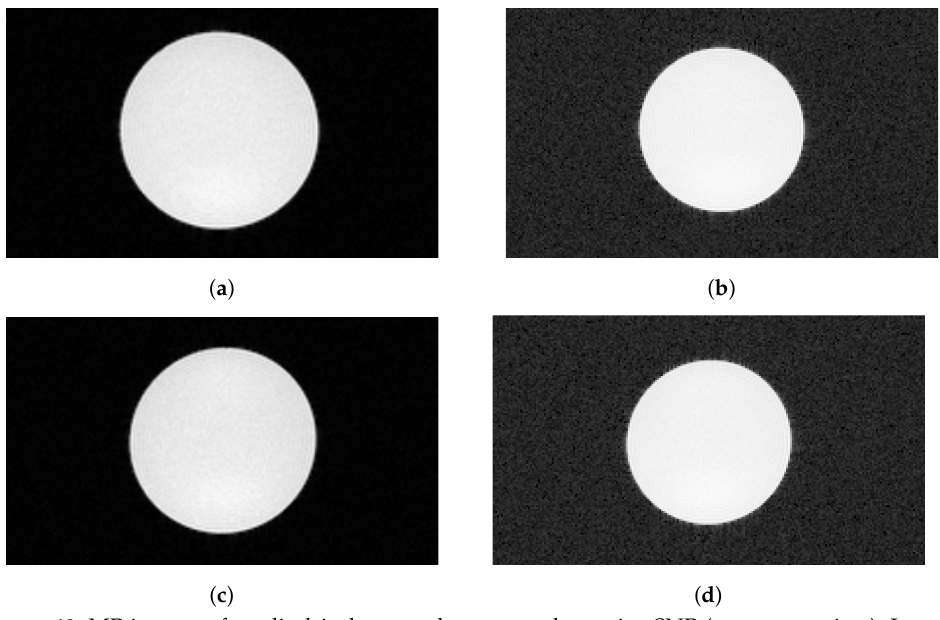
Figure 13. MR images of a cylindrical water phantom to determine SNR (transverse view). Images taken in parallel to data recording with the SAFIR insert inside the MRI machine during readout at low decay rate (top row) and during the high-rate test (bottom row). ( a ) Standard image, readout, ( b ) Modified greyscale version, readout, ( c ) Standard image, high-rate test, ( d ) Modified grayscale version, high-rate test.